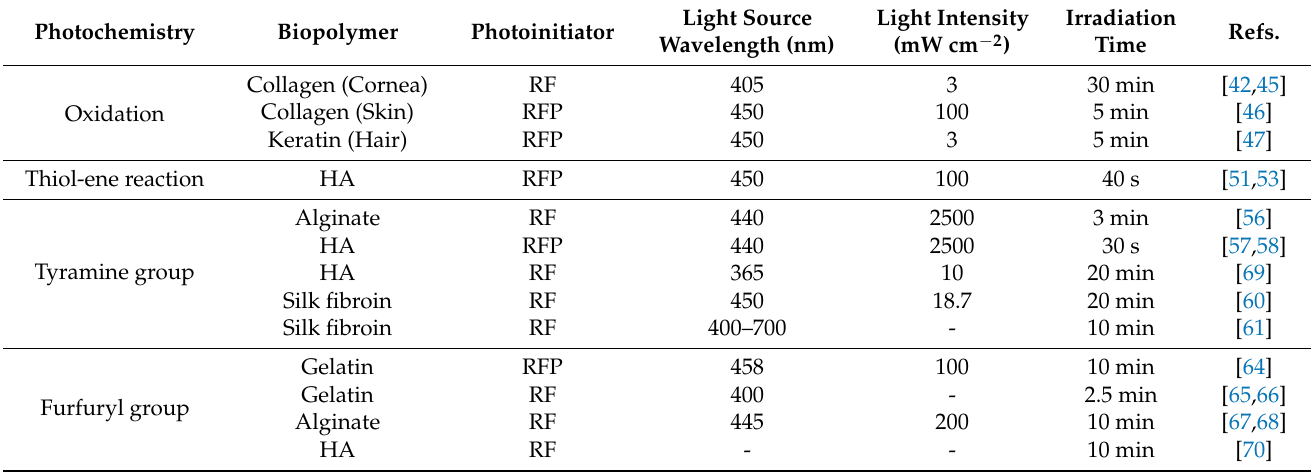
Table 2. Types of RF-induced photochemistry and crosslinked biomaterials.